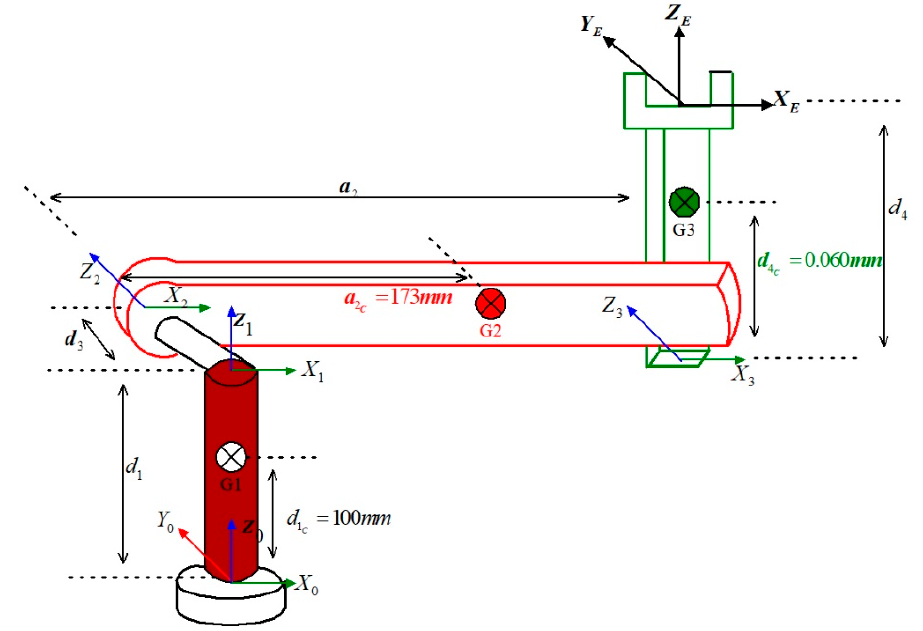
Figure 1. The model of the first three links of Staubli RX-60 robot arm [27].